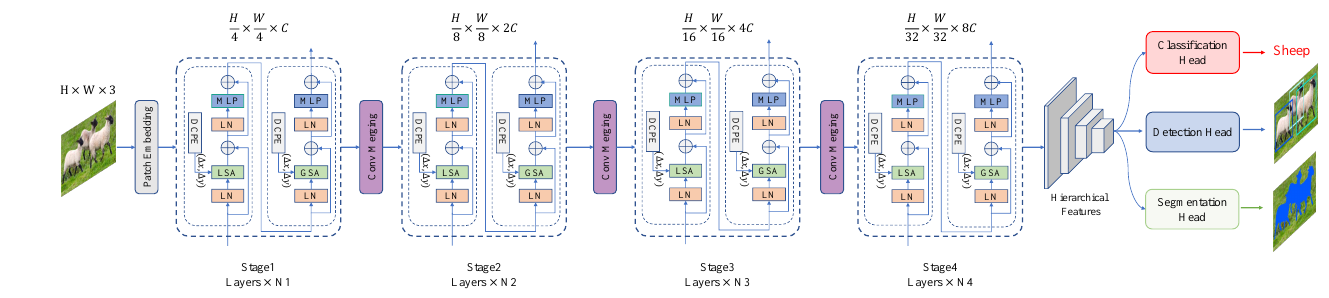
Figure 2. The overall architecture of our proposed LGViT, which can be applied to extract hierarchical feature representation for various visual tasks through four stages. Note at each stage, the inner structure is composed of two successive LGViT Blocks, and the LSA and GSA modules are designed to handle both short and long-range dependencies to extract better contextual information. LN means layer